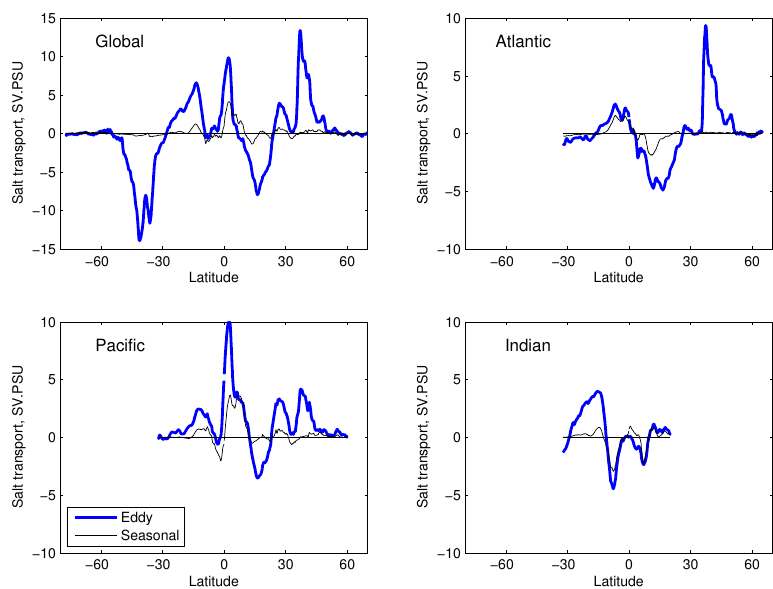
Fig. 6. Eddy and seasonal contributions to the meridional transport of salt in the ORCA12 simulation.